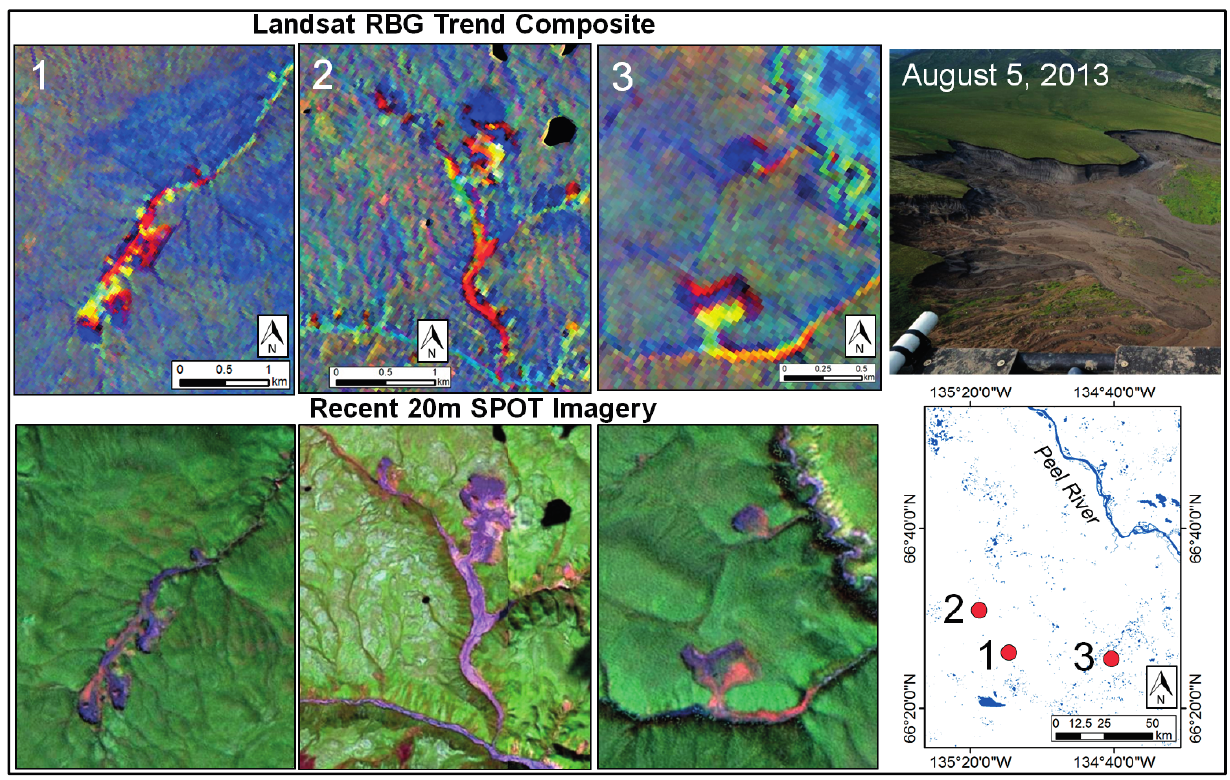
Figure 11. Example TC trend images for three retrogressive thaw slumps within the Peel Plateau region ( top ) with recent SPOT imagery ( bottom ) and an air photo (top right) shown for